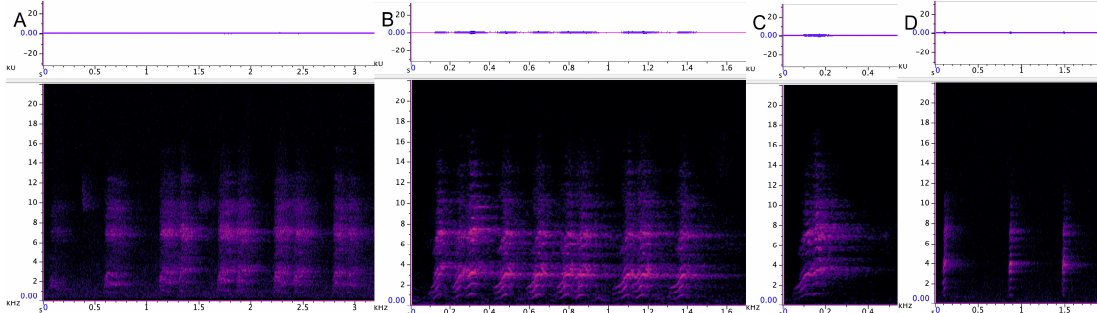
Figure 9. Paragalago calls (upper images: waveform, lower images: spectrogram). ( A ) Incremental call is used as a contact call and for maintaining inter-individual spacing during the night (Sound S15). It is used in the group assembly chorus in the morning and, less intensely, in the evenings. The call tends to grow incrementally towards the end. ( B ) Chatter is a mobbing call, used repeatedly with other mobbing calls chirrup and yap, usually in groups (Sound S16). ( C ) Chirrup is a mobbing call, and a single unit of chatter (Sound S17). It is used together with other mobbing calls, chatter and yap. ( D ) Yap is mobbing call and may be repeated hundreds of times with other mobbing calls, especially when the animals are agitated (Sound S18).